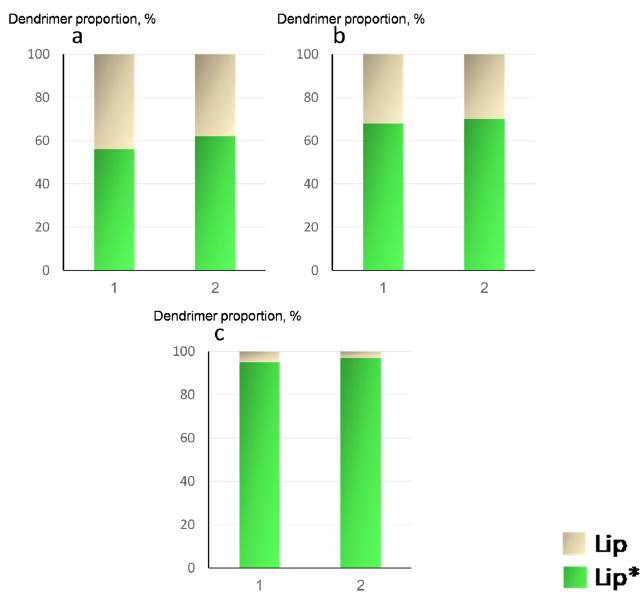
Figure 8. Diagrams of distribution of dendrimers between labeled (Lip*) and unlabeled (Lip) lipo- somes in 1.5 h for D 350+ ( a ), D 229+ ( b ), and D 215+ ( c ). The ratios of the ionic groups were [+]/[ − ] = 0.5 (1) posomes in 1.5 h for D 3 50+ ( a ), D 2 29+ ( b ), and D 2 15+ ( c ). The ratios of the ionic groups were and 1 (2). CL/Chol/DOPCliposomes, [CL] = 1.5 × 10 − 4 mol/L, total lipid concentration of 1 mg/mL. [+]/[ − ] = 0.5 (1) and 1 (2). CL/Chol/DOPC liposomes, [CL] = 1.5 × 10 − 4 mol/L, total lipid concen- 10 − 3 M phosphate buffer, pH 7.2. tration of 1 mg/mL. 10 − 3 M phosphate buffer, pH